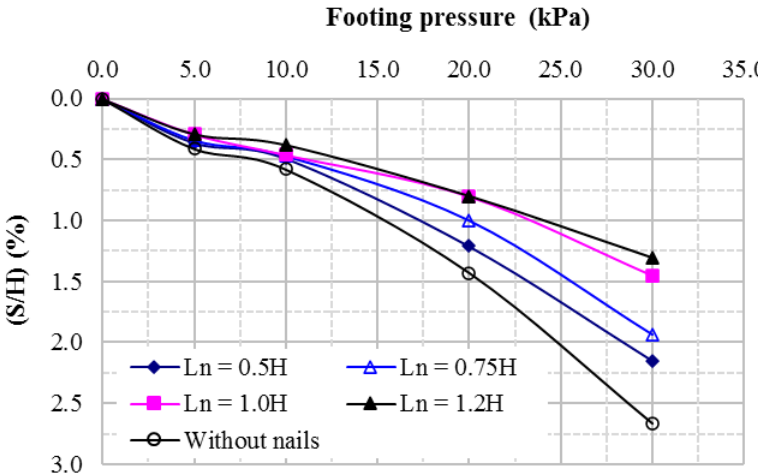
Figure 6. Effect of nail length on the horizontal movement of the middle of the slope.